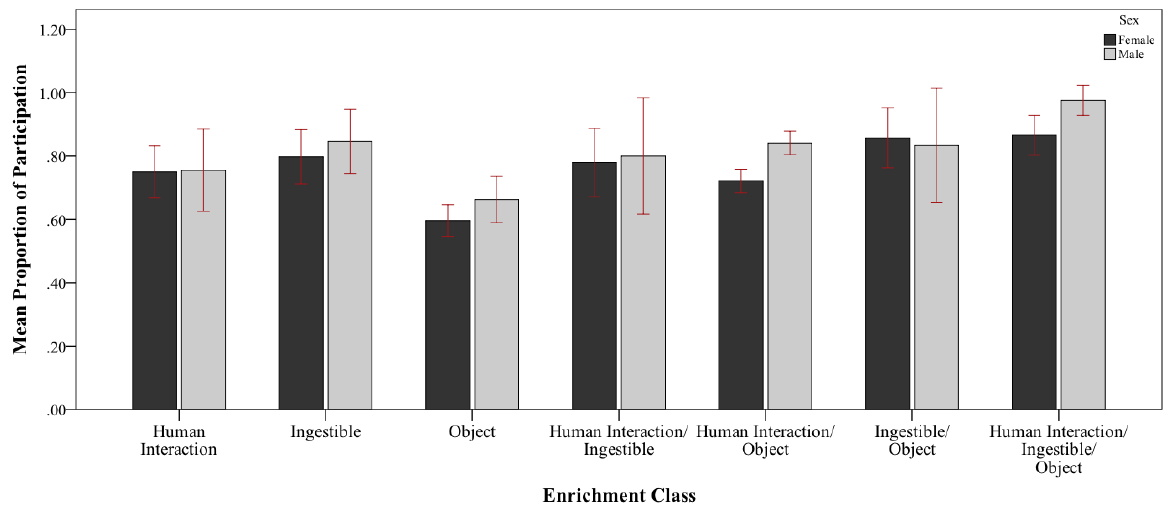
Figure 4 . Mean (±2SE) proportion of males ( n = 7) and females ( n = 12) that participated with each enrichment class, including all trials and